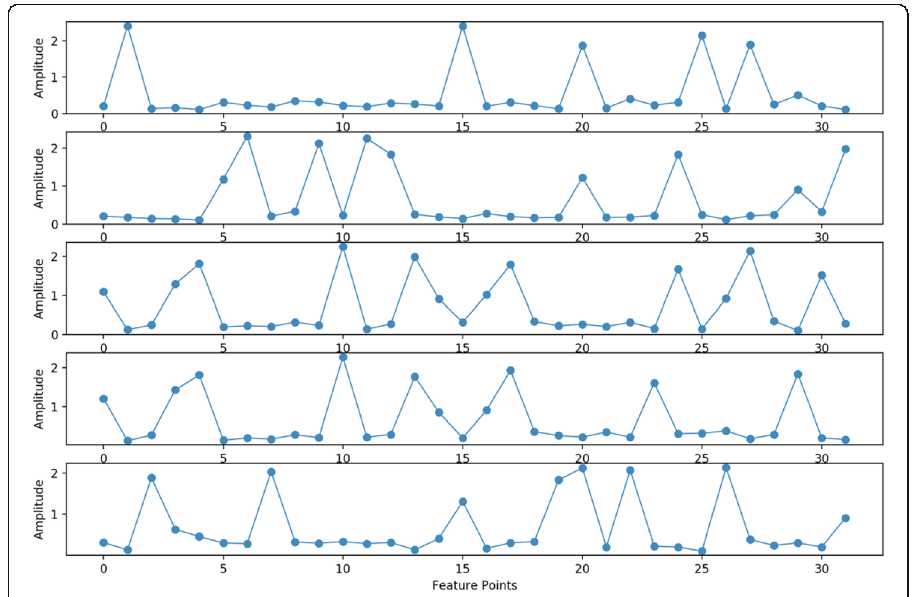
Fig. 16 batch chip feature map of A1637